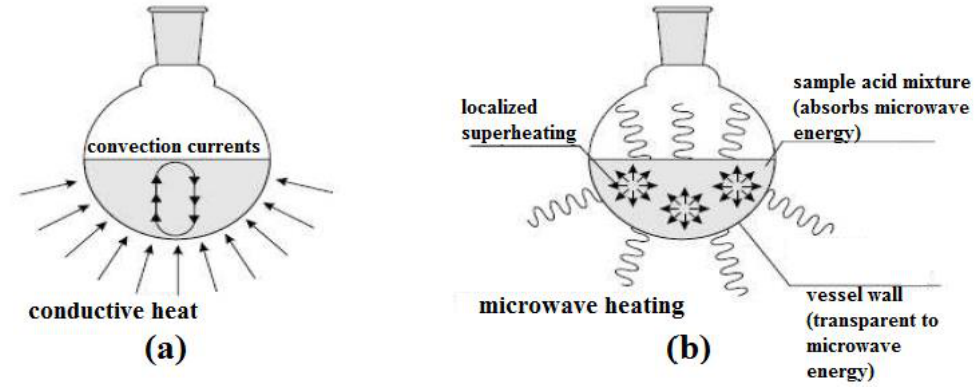
Figure 3 . Heating mechanisms for: ( a ) conventional heating, and ( b ) microwave heating [43]. Table 5. Comparison between microwave heating and conventional heating.